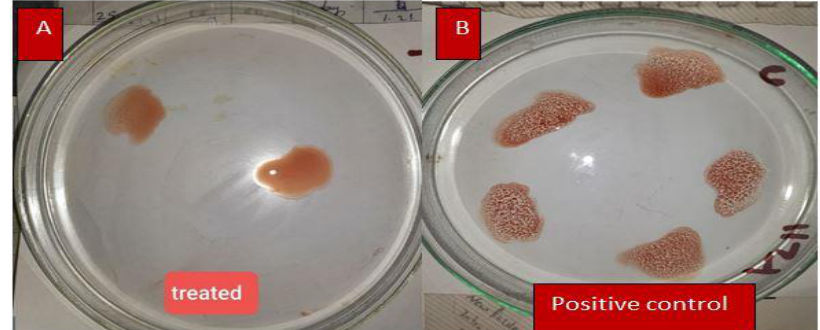
Fig. 2: Haemagglutination activity of NDV genotype VII in the treated group with ECV extract and control one: Comparison between (A): treated group showed loss of haemagglutination activity and (B): control positive group in which NDV has the ability to agglutinated RBCs